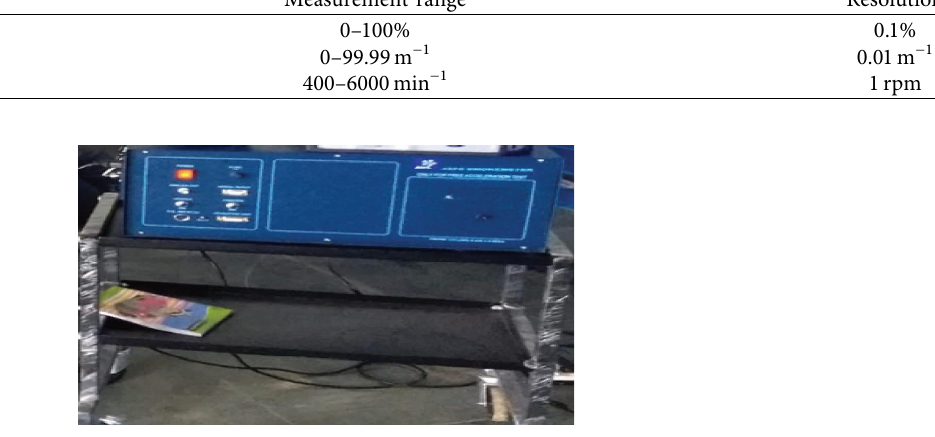
Figure 3: AVL 437C smoke